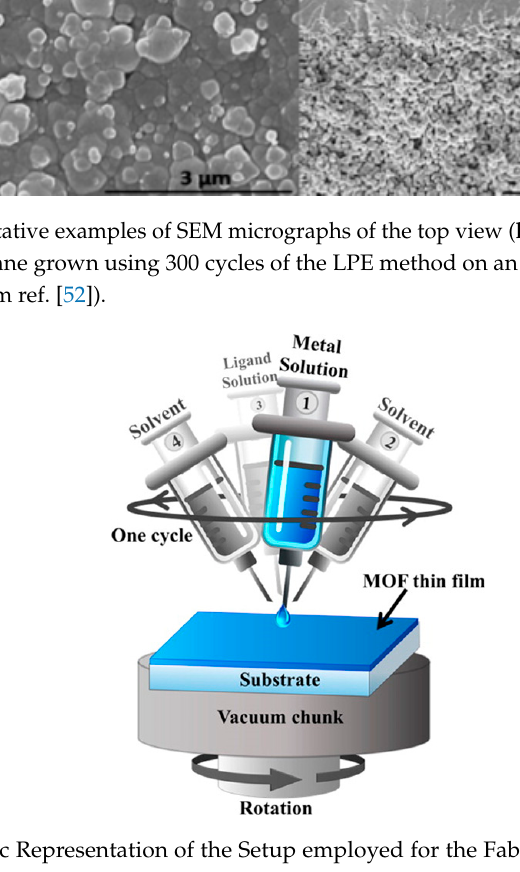
Figure 17. Schematic Representation of the Setup employed for the Fabrication of MOF Thin Films Using the LPE Approach Adapted to the Spin Coating Method (adapted with permission from ref. [54]).